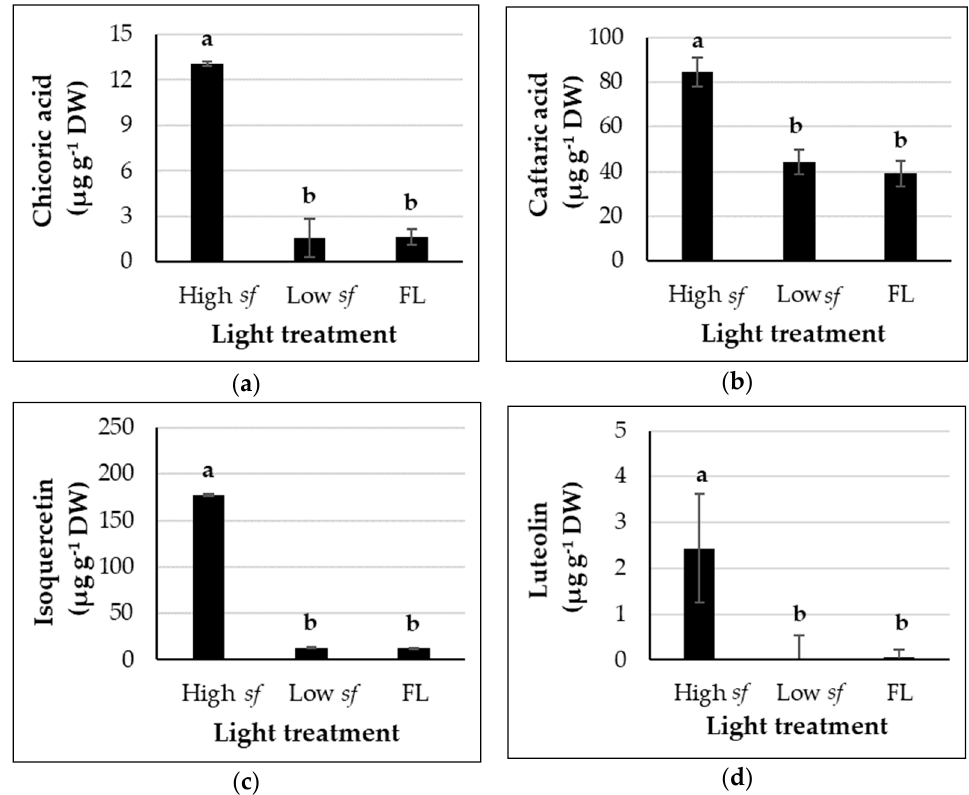
Figure 2. Effect of different lighting treatments on the concentration of the most abundant phenylpropanoids detected in lettuce leaves ( n = 3), as follows: chicoric acid ( a ), caftaric acid ( b ), isoquercetin ( c ), and luteolin ( d ). Vertical bars represent standard deviations. Different letters indicate significant differences at p ≤ 0.05.